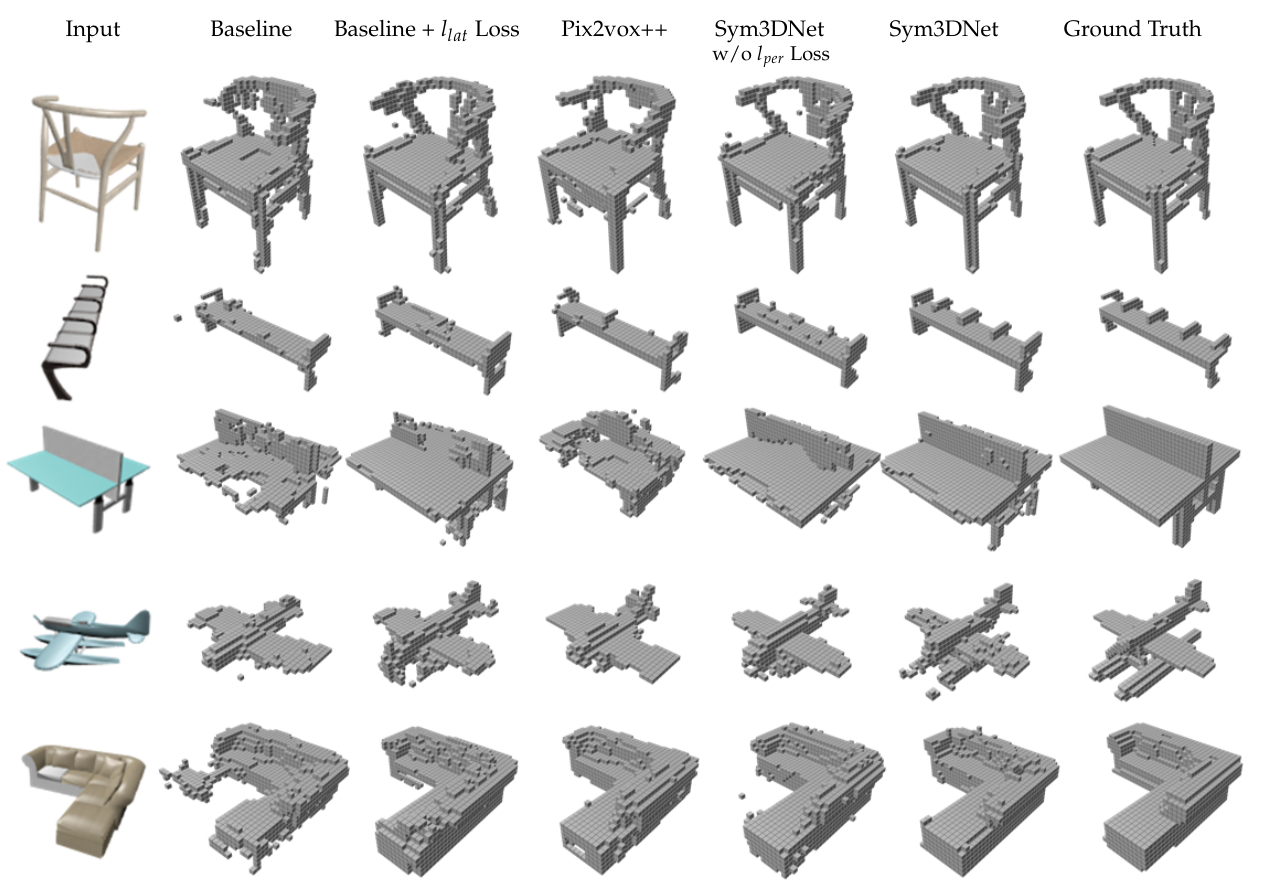
Figure 4. The effects of symmetry fusion, perceptual loss and 3D embedding in single view 3D reconstruction and comparison between baseline and state-of-the-art method Pix2vox++ [11]: Baseline network consists of 2D image encoder and 3D decoder without symmetry fusion module. We provide 3D embedding from 3D shape encoder for baseline (with l lat ) network. We also compare Sym3DNet without perceptual loss ( l per ).